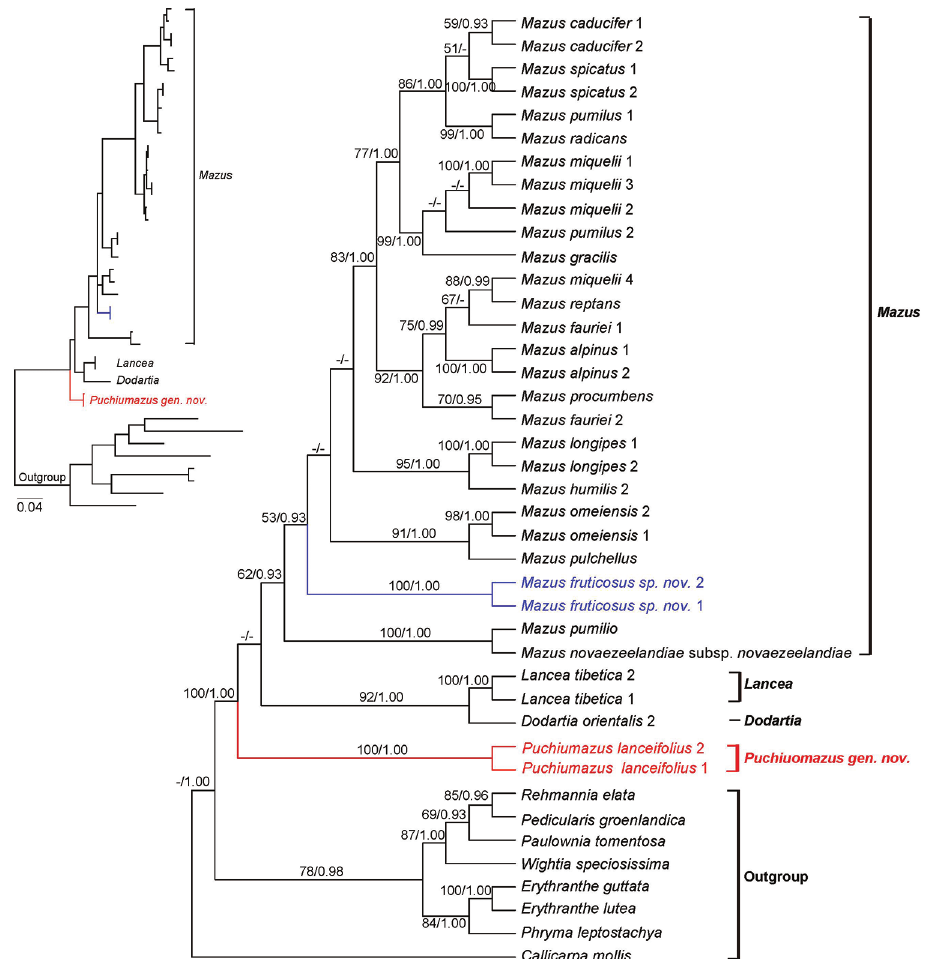
Figure 4. Maximum Likelihood phylogram of Mazaceae as inferred from analysis of nrITS. Support values ≥ 50% BS or 0.90 PP are displayed near the branches following the order